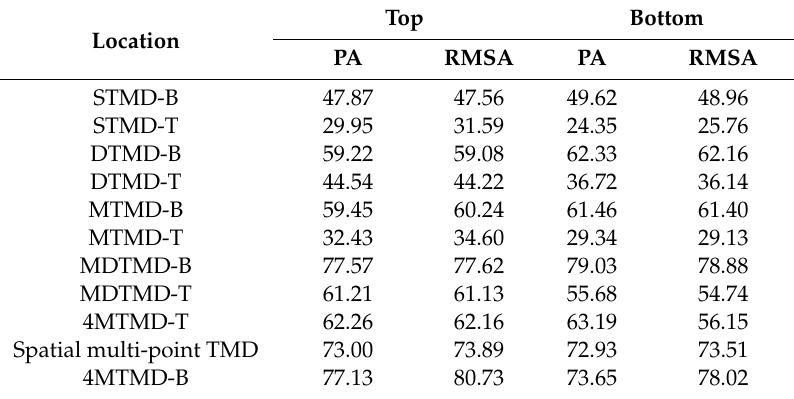
Figure 7. Structural responses of original structure and vibration-damping structure under simple harmonic excitation in various conditions: ( a ) peak acceleration and ( b ) root mean square (RMS) acceleration. Table 3. Attenuation rates of TMD under various conditions